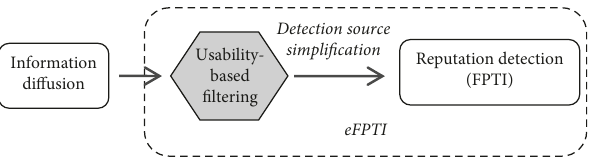
Figure 5: The enhanced FPTI model